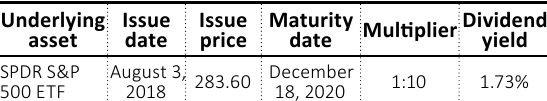
Source: Yahoo Finance (2018).